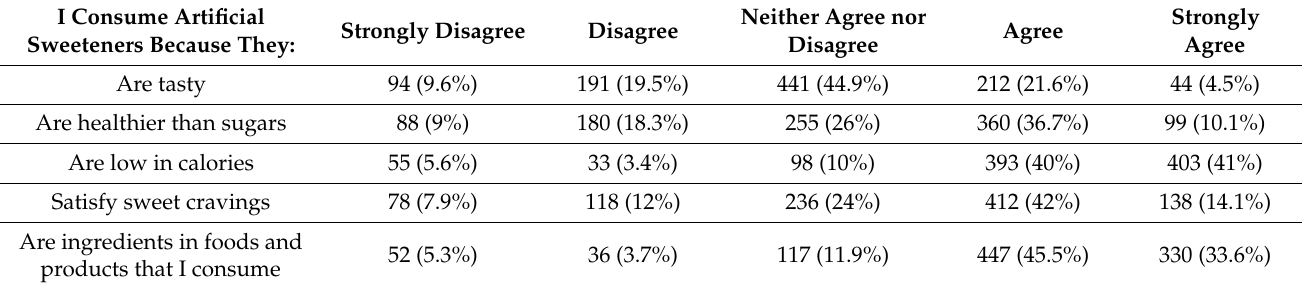
Figure 1. Food and drink sources of non-nutritive sweeteners (NNS) in the survey sample. Values represent percentages of responses to a multi-choice question. Table 2. Reasons for consuming